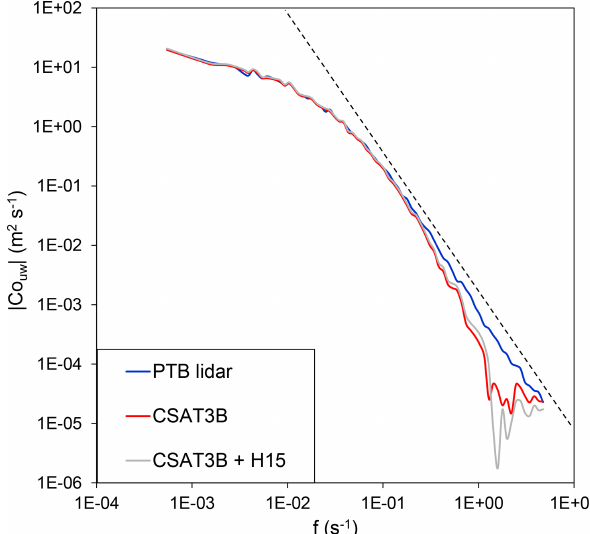
Figure 8. Ensemble co-spectra between u and w (absolute value) based on turbulence measurements from the PTB lidar and the CSAT3B sonic anemometer. The dashed line indicates the theoreti- cal − 7 / 3 power law in the inertial